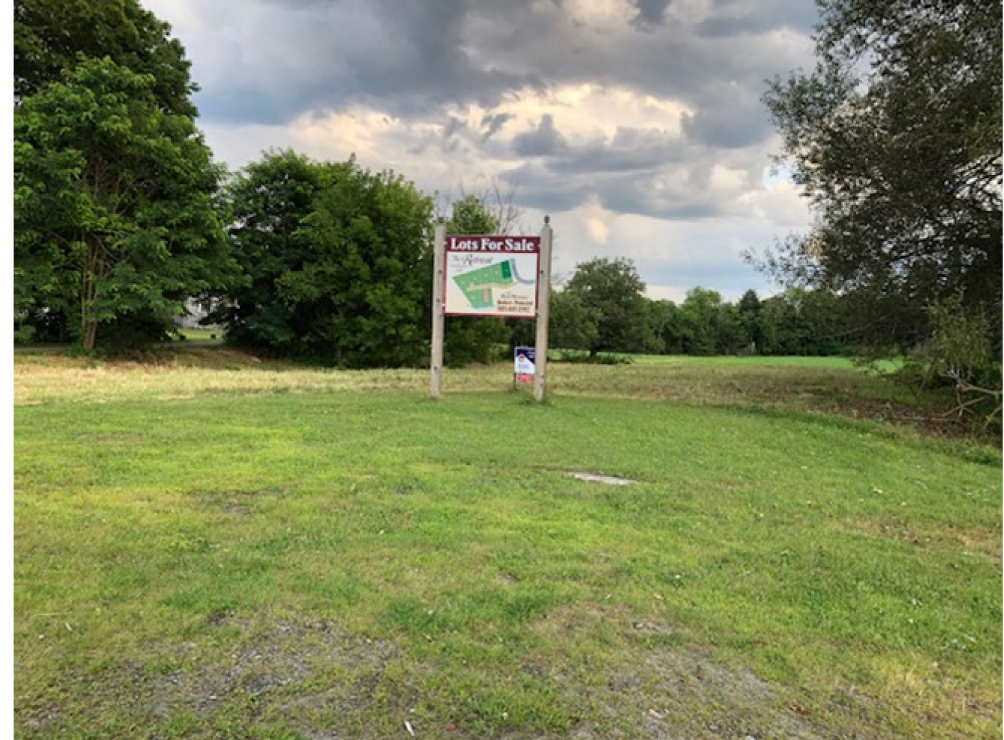
Figure 10. From transect across Central Maine: Stage 1–In Memory. Location of former auto repair shop that stood where the subdivision sign is in Industry, Maine. (Photo courtesy of Betty